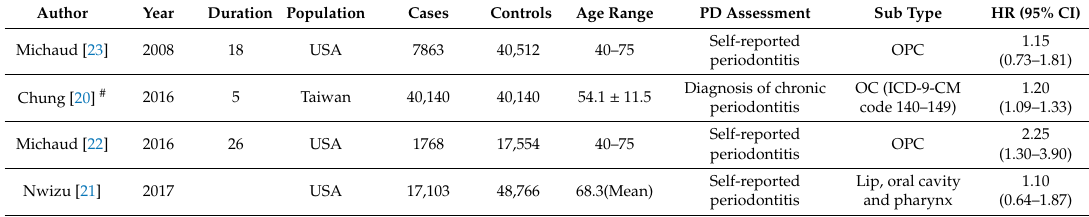
Table 2. Characteristics of the selected cohort studies in detail.